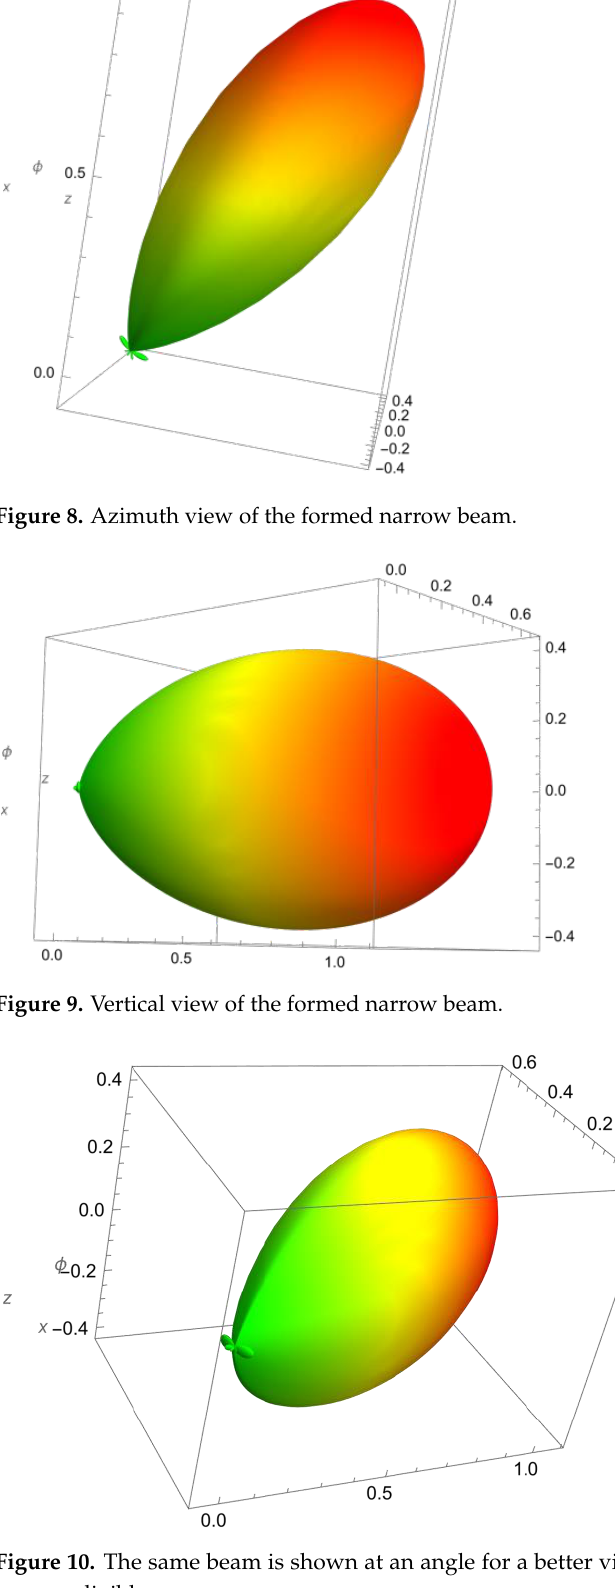
Figure 10. The same beam is shown at an angle for a better view of the side lobes. The side lobes have negligible have negligible energy.